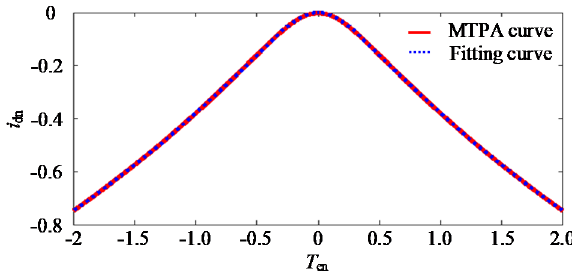
Figure 3. MTPA and the fitting curve.